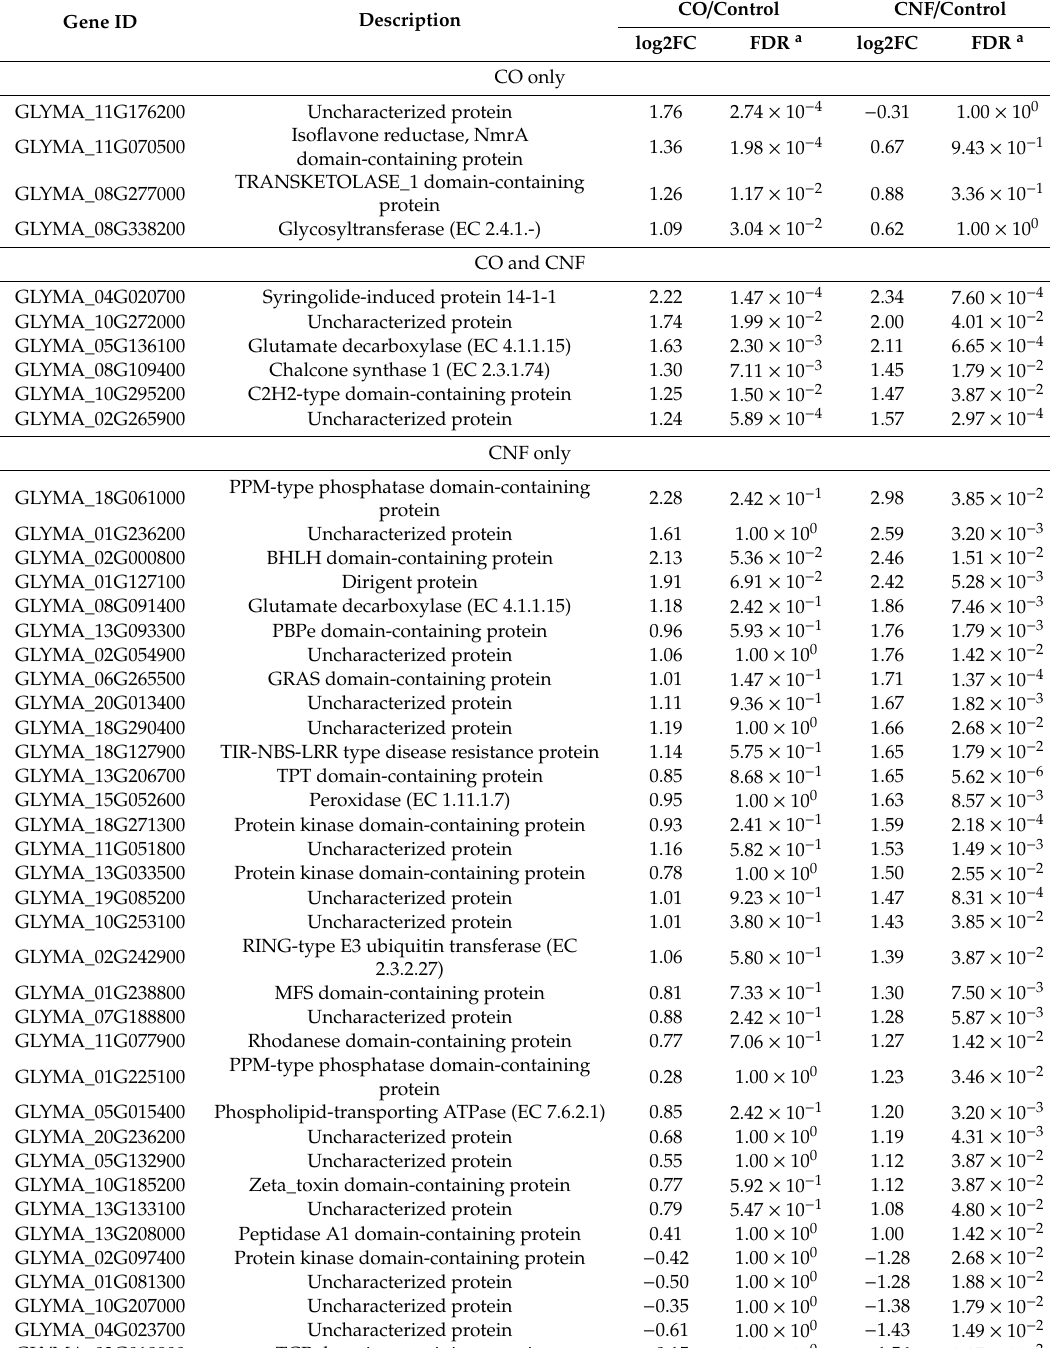
Table 1. Significantly di ff erentially expressed genes (DEGs) in chitin oligosaccharides (CO) and / or chitin nanofiber (CNF)-treated soybean